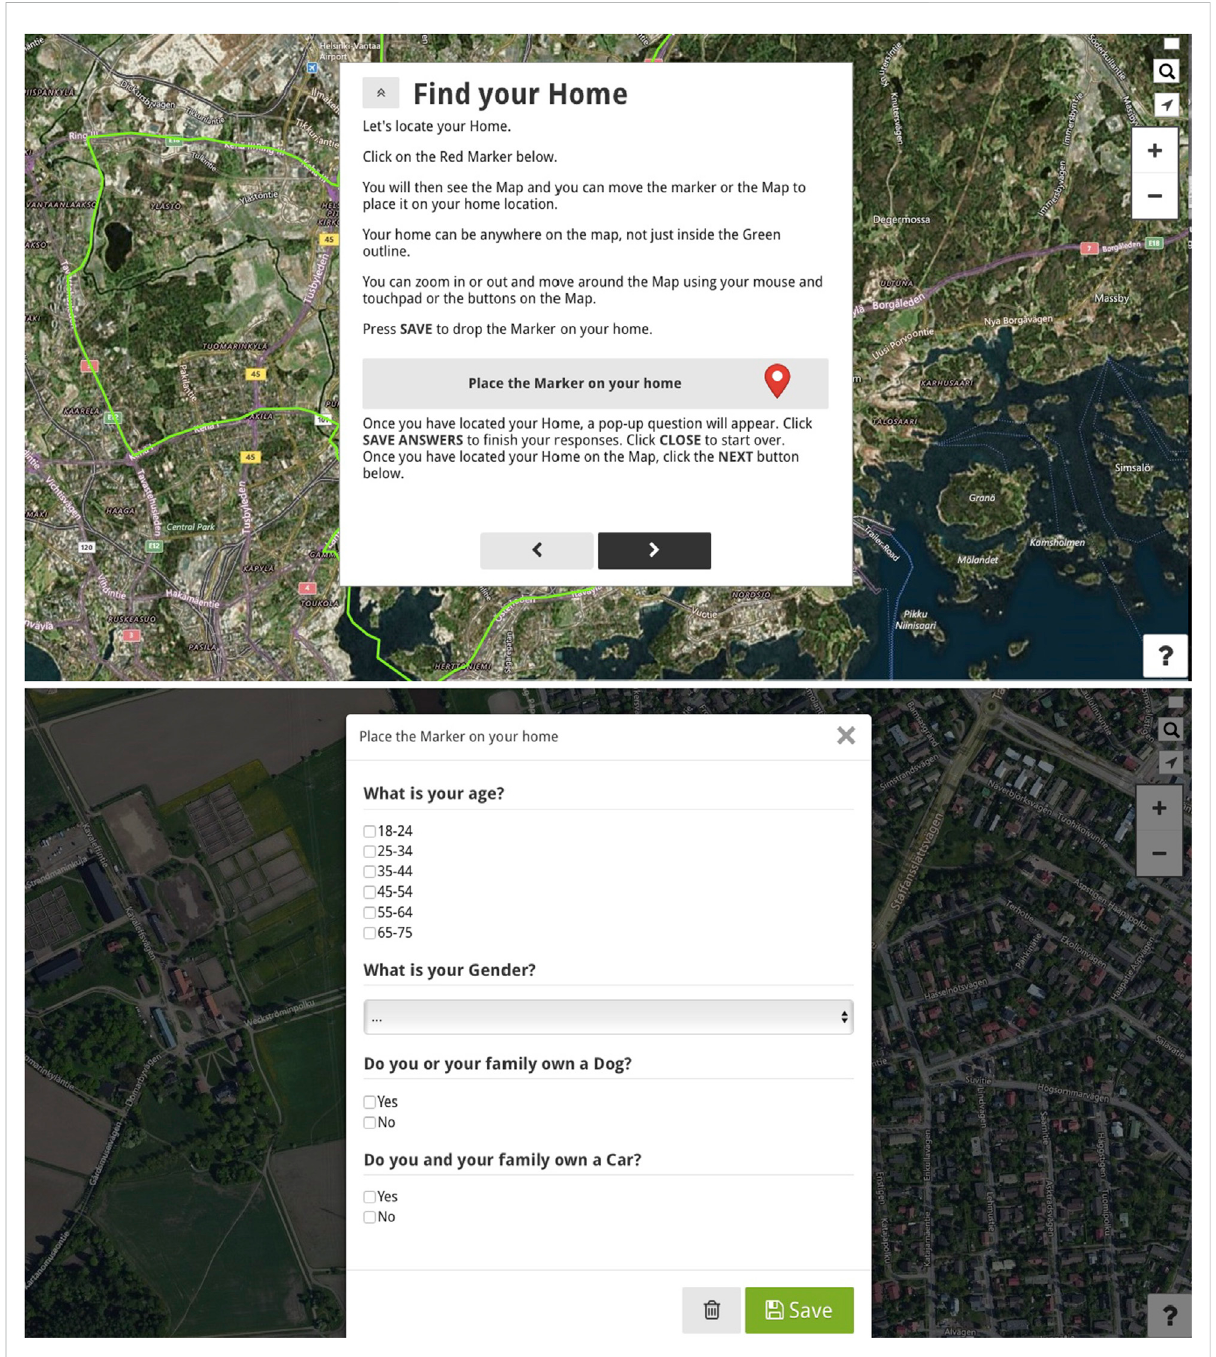
Figure 2. This questionnaire did not ask for any socio- economic data such as income and education level. The questionnaire asked for respondents over the age of 18